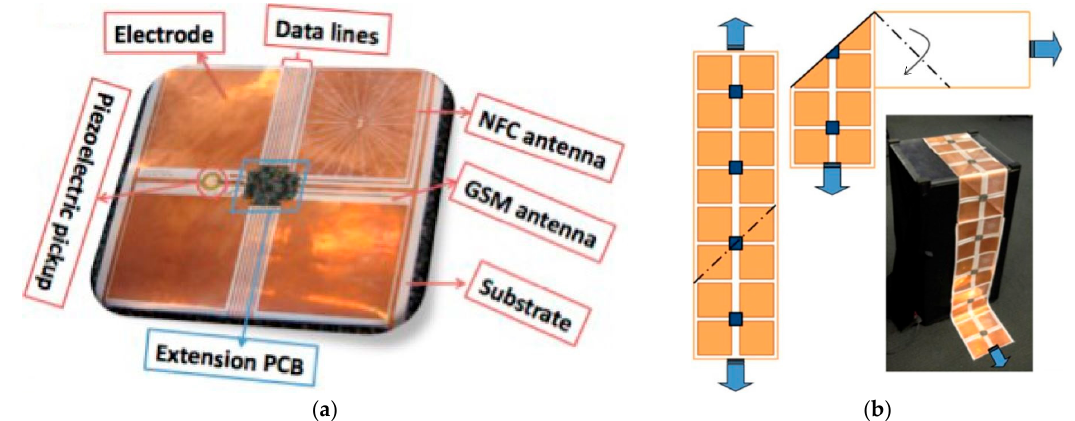
Figure 3. ( a ) A single sensing tile consists of the substrate along with a PCB module (redrawn from [64]). Four different electrodes in each sensing tile transmit four unique signals during footstep detection; ( b ) Demonstration of the folding mechanism for adapting the surface geometry using a single substrate without any cutting or joining.